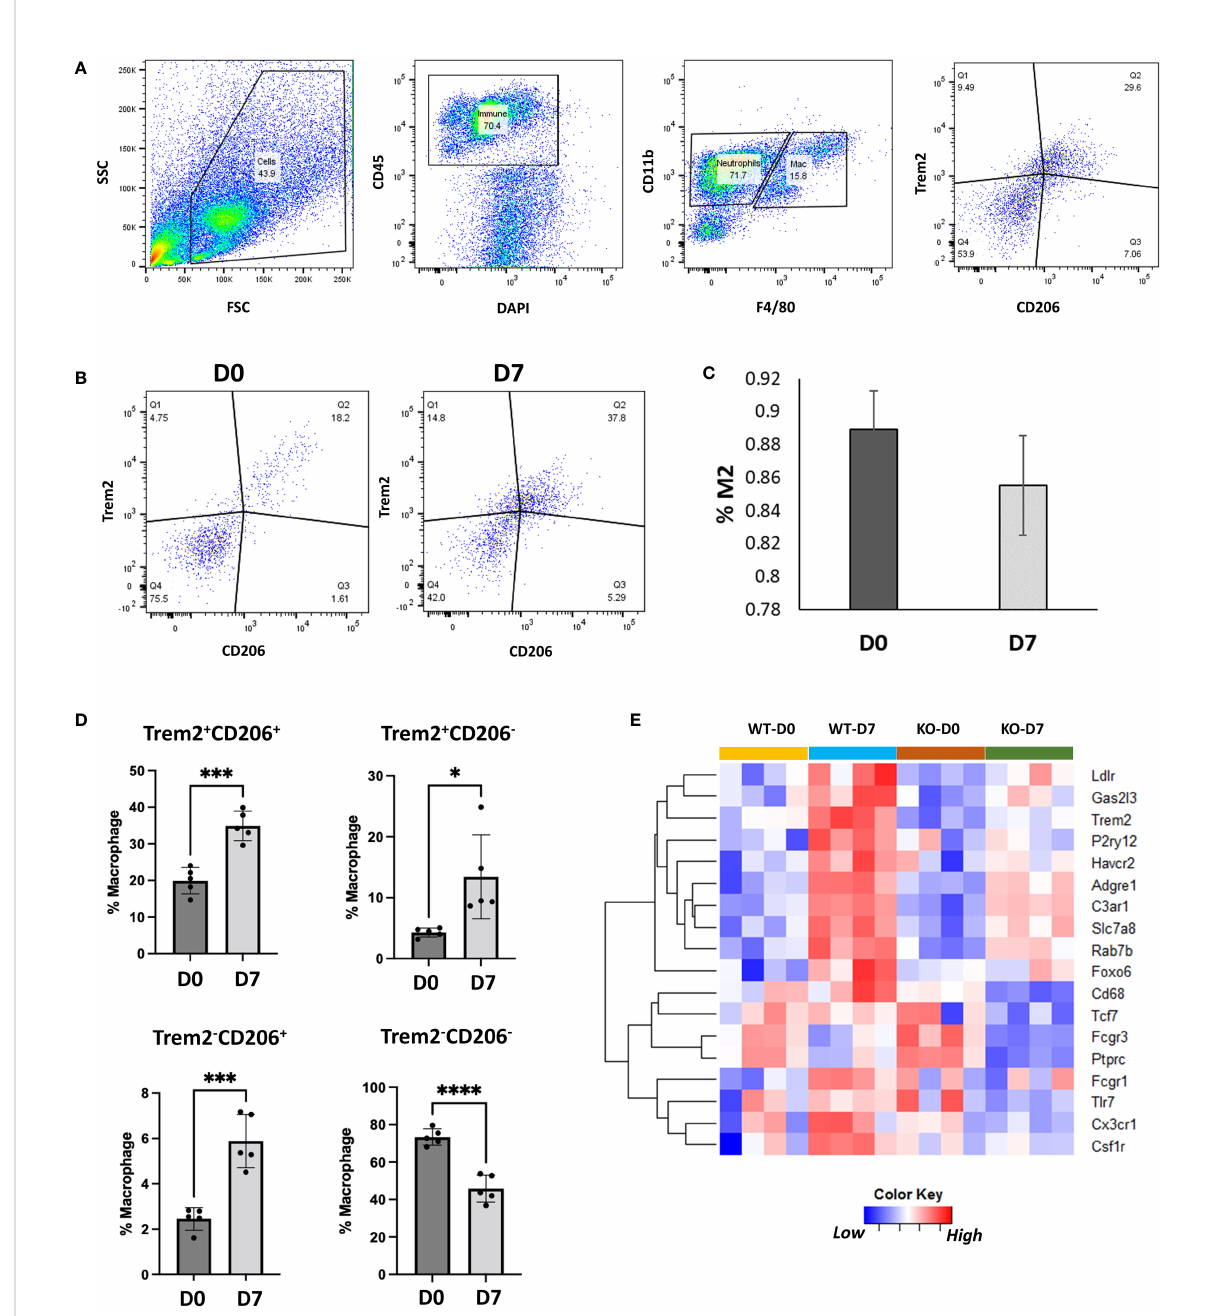
FIGURE 7 Characterization of Trem2-expressing macrophages using fl ow cytometry. (A) Flow cytometry gating strategy to identify Trem2-expressing M2- like macrophages. (B) Flow cytometry plots showing Trem2+ M2-like macrophages at D0 and D7. (C) Proportion of Trem2+ macrophages among M2-like macrophages at D0 and D7. Data is represented as mean ± SD. (D) Proportion of Trem2 and CD206- expressing macrophages relative to all macrophages. Data is represented as mean ± SD. *p ≤ 0.05; ***p ≤ 0.001; ****p ≤ 0.0001 (two-sided unpaired t-test). (E) Genes differentially expressed between injured joints of wildtype (WT) and Trem2 -/- (KO) mice at